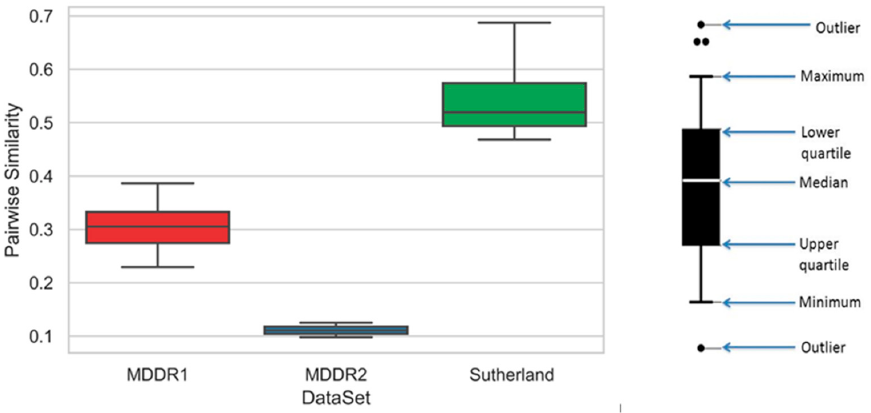
Figure 15. Comparison of MPS values of the three databases using boxplot.